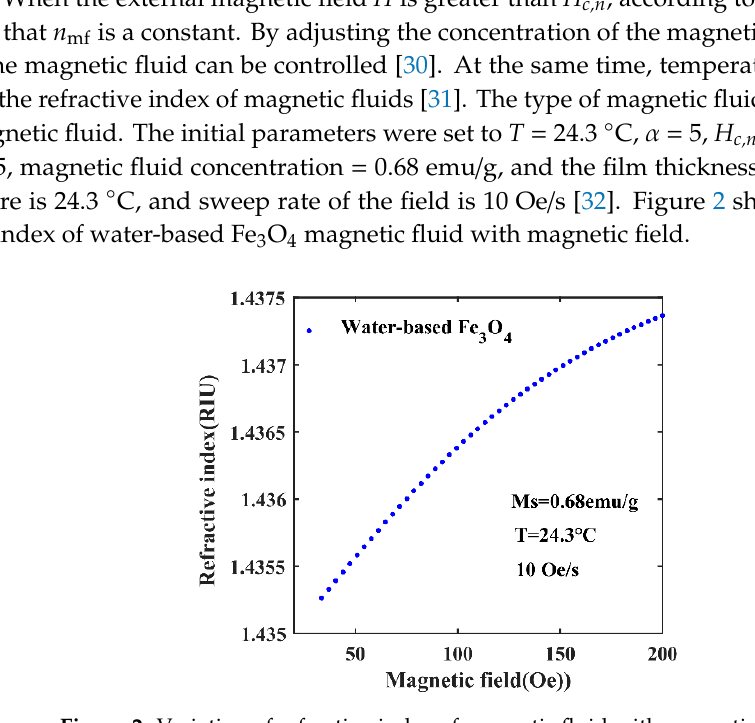
Figure 2. Variation of refractive index of magnetic fluid with magnetic field.